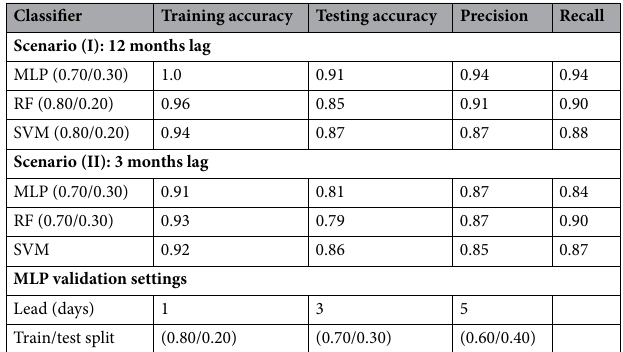
Table 2. CA prediction performance for 12- and 3-months lag